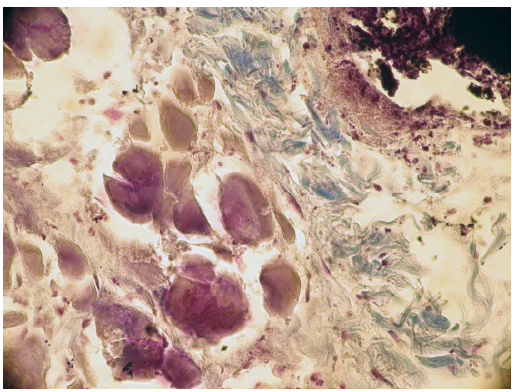
Figure 6. Calcification of muscular fibers from the skin. Col. Trichrome Masson, ×200 .